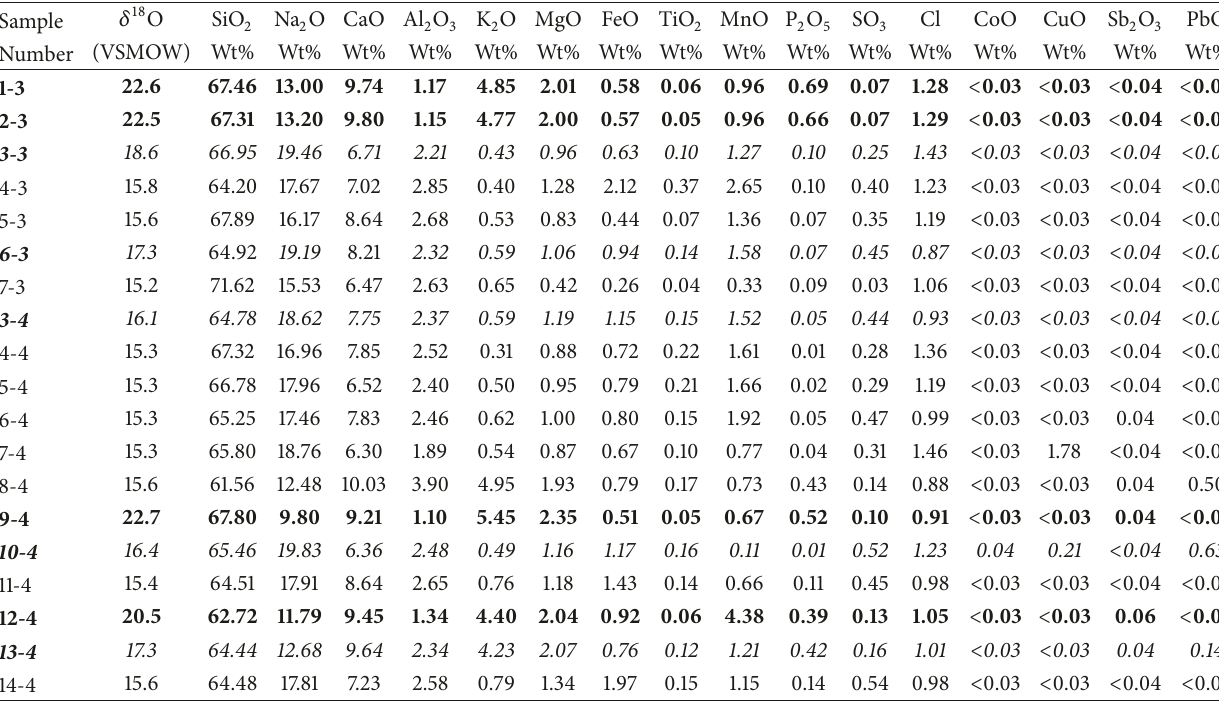
Table 4: Isotopic and chemical composition of Roman and late Antique glasses from Thessaloniki, 1st–6th centuries AD in age. Samples with moderate and strong 18 O enrichment are in italics and bold font, respectively. Note that NiO, ZnO, and SnO 2 contents are not reported because they are lower than EMPA detection limits for all samples (LOD of NiO = 0.03 wt%; LOD of ZnO and SnO 2 = 0.04 wt%). 18 Sample 𝛿